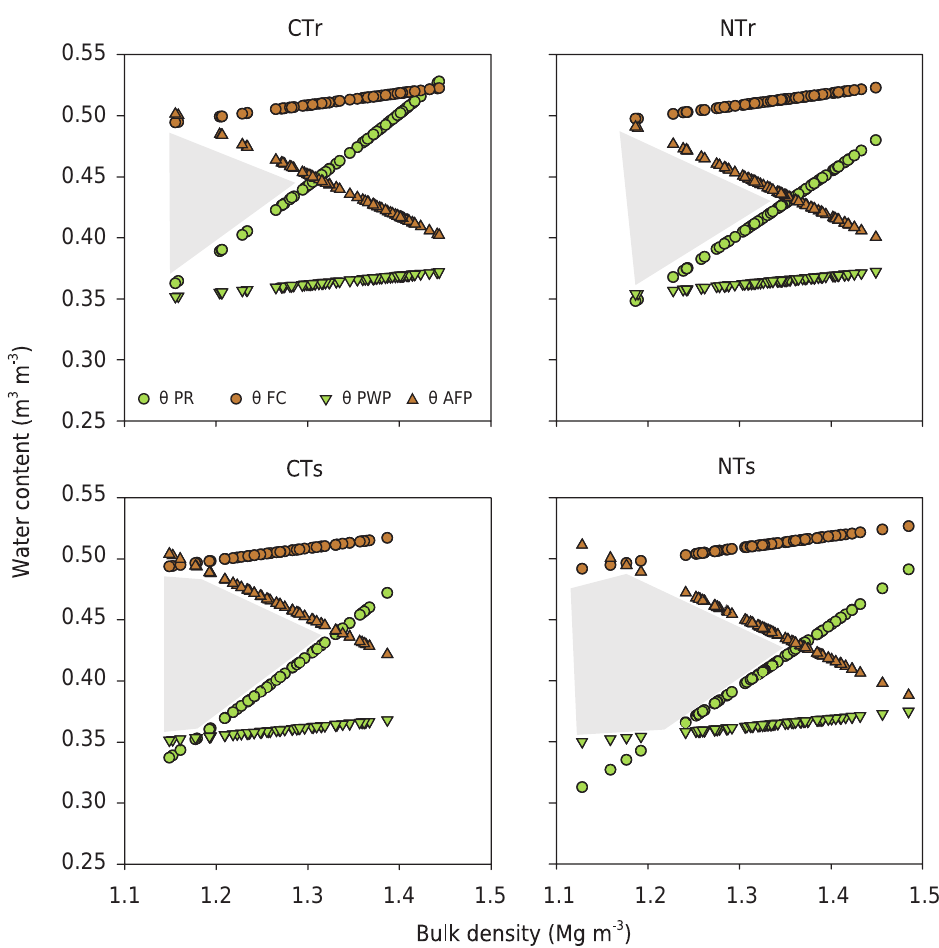
Figure 3. Variation in soil volumetric moisture at field capacity (θFC), permanent wilting point (θPWP), aeration porosity at 0.10 m 3 m -3 (θAP), and penetration resistance (θPR) as a function of density for a Ferralsol under conventional tillage (CT) and no-tillage (NT) with crop rotation (r) and succession (s). The grey area represents the least limiting water range (LLWR).